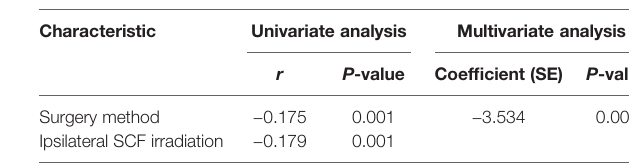
TABLE 5 | Univariate and multivariate regression analyses of incidental IMC dose